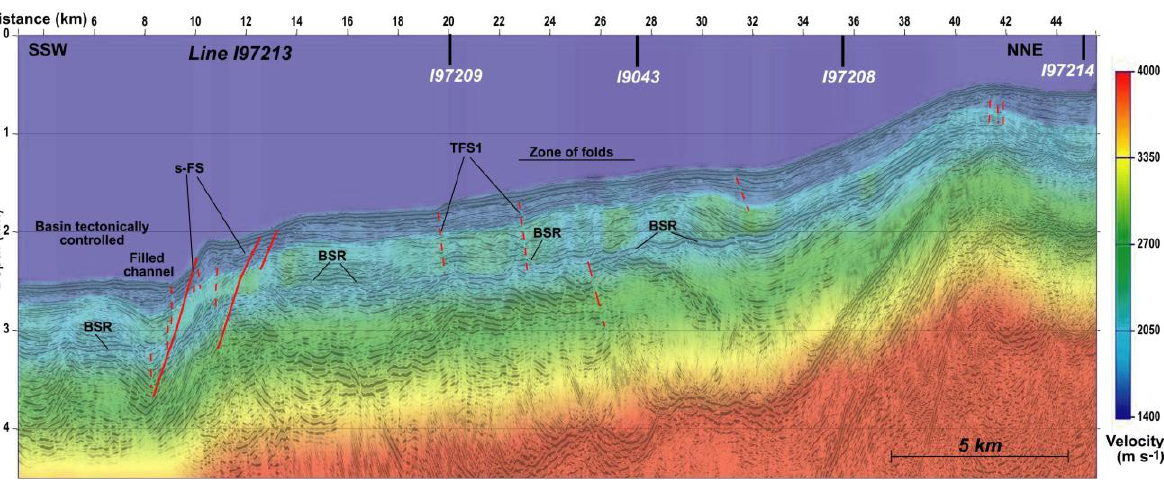
Figure 5. PreSDM section of line I97213, on which the velocity model is superimposed. The s-FS, the TFS1, the BSR and the main geological features are indicated. Vertical exaggeration 1:4. Minor faults (red dashed lines) and major faults (red thick lines) are indicated. Crossing lines are reported.